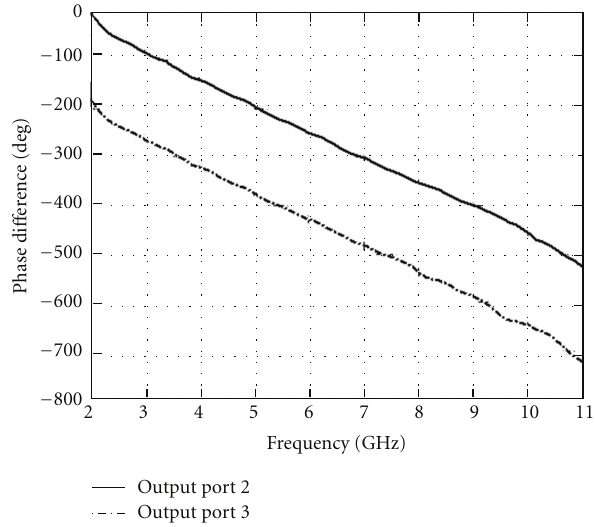
Figure 4: Measured output phase di ff erence of the UWB Minkowski branch line coupler.